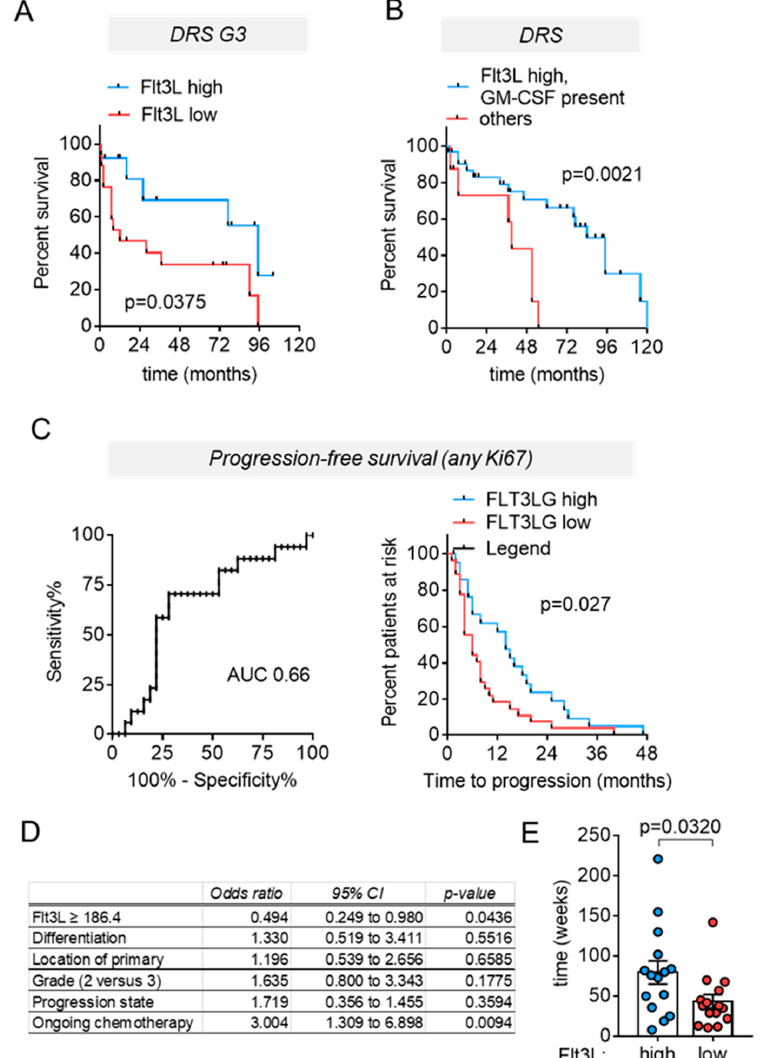
Figure 5. Circulating Flt3L is a prognostic biomarker in NEN. ( A ) Kaplan–Meier curves illustrating disease-related survival of patients with G3 tumors that exhibit above or equal (high) or below (low) cut-off levels of circulating Flt3L (cut-off at 169 pg/mL as determined from ROC curves at 12 months). Median DRS was 95 months in patients with high Flt3L serum levels versus 12 months in patients with low circulating Flt3L (HR 0.3694, 95% CI 0.1466 to 0.9308, logrank test). ( B ) DRS of patients stratified according to Flt3L and GMCSF. Shown are data for the subgroup of patients for which GM-CSF determinations were available ( n = 40, median survival 76 months). Mean ± SEM of GM-CSF was 9.2 ± 2.4 pg/mL, if detectable. Patients with either above mean circulating Flt3L, or detectable GM-CSF, or a combination thereof had better DRS than the remaining patients. Kaplan– Meier estimates of median survival were 95 and 46 months, respectively; HR 0.287, CI 0.0862 to 0.958. ( C , left panel) ROC curve for circulating Flt3L in patients with or without disease progression at 12 months. ( C , right panel) Kaplan–Meier estimates of progression-free survival (PFS), indicating median PFS of 14 versus 6 months in patients with circulating FLt3L above or below cut-off ( n = 22 and 27, respectively, cut-off 186.2 pg/mL; HR 0.557, 95% CI 0.314 to 0.989, logrank test. ( D ) Multivariate Cox regression analysis of PFS. ( E ) Comparison of disease stabilization periods in tumors with Ki67 > 10% following stratification by > mean (high, n = 15) or < mean (low, n = 15) circulating Flt3L, Mann–Whitney test.